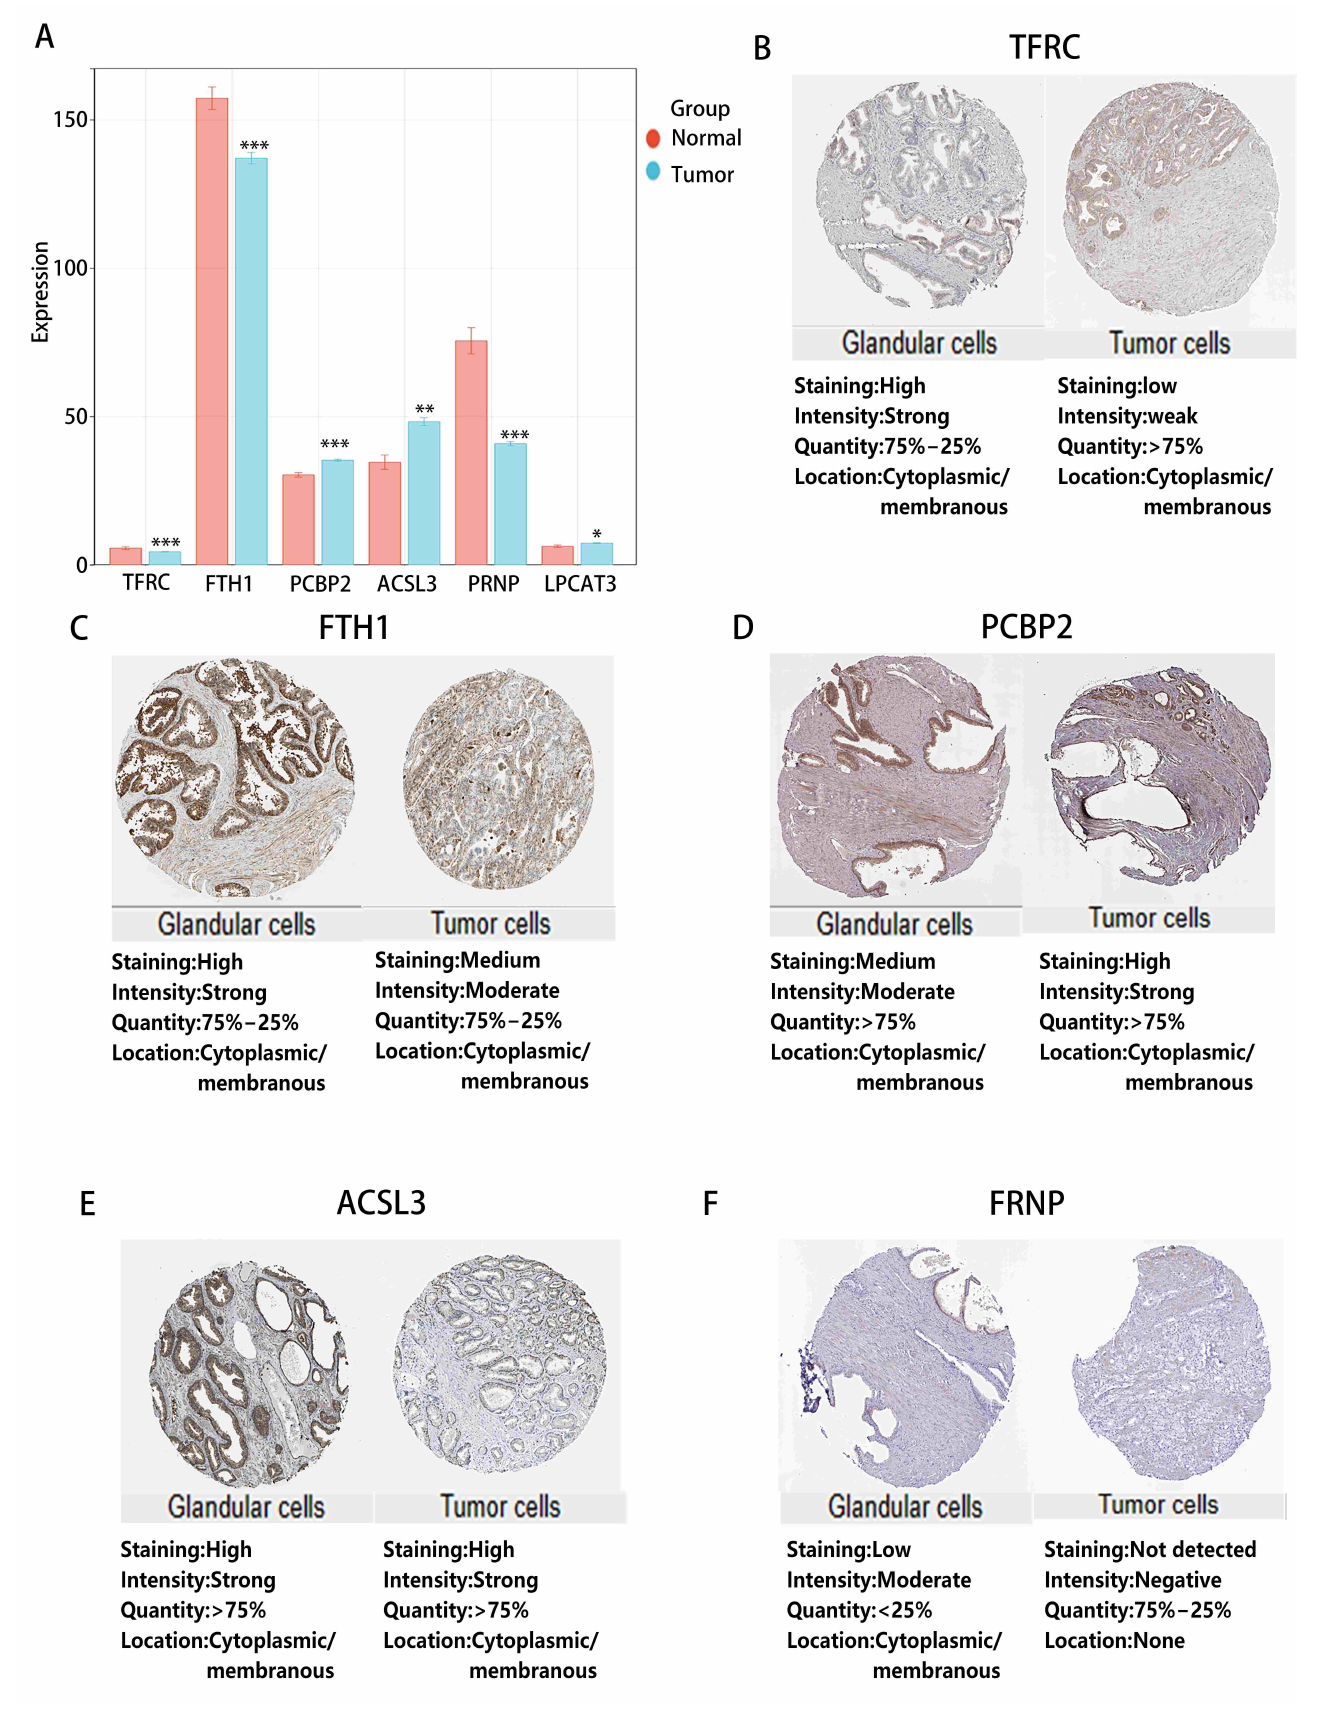
FIGURE 8. The expression and prognostic value analyses of each signature. (A) The expression of 6 signatures in the PRAD group in comparison with the normal group. (B–F) The protein level of signatures in